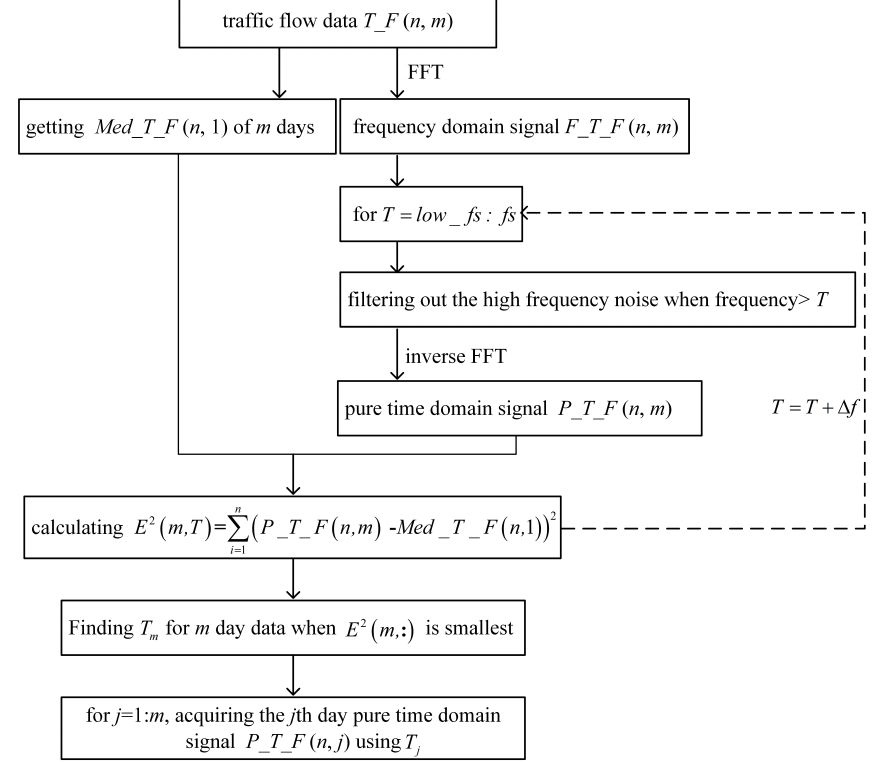
Figure 5. Flowchart of the adaptive cuto ff frequency selection (A-CFS)